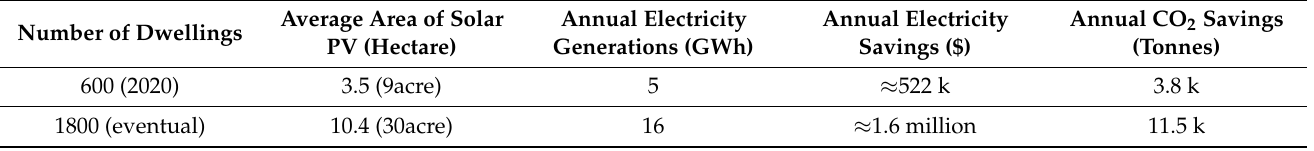
Table 10. Savings from the community solar (Serenbe).